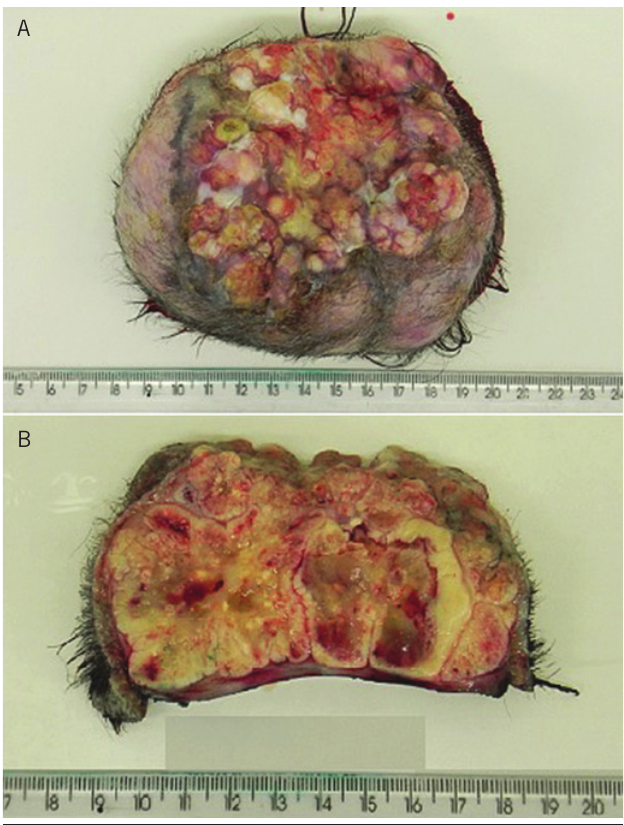
figurE 2 − Macroscopic aspect A) skin and subcutaneous cellular tissue segment centered by vegetating bulky lesion, brown-clear with granular areas, lobulated, measuring 10 × 7 cm; B) variegated cut surface with brown-clear and smooth areas, port-wine and softened areas.